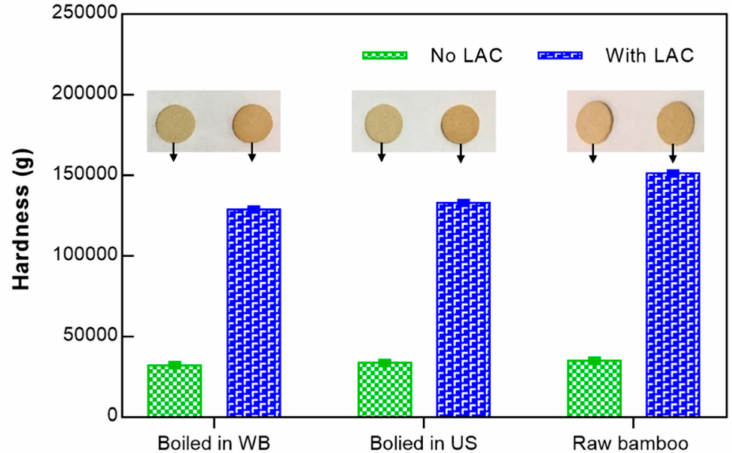
Figure 5. The hardness of the raw bamboo tablets and of the bamboo tablets produced after 30 min of boiling using a water bath and an ultrasonic bath; the tablets were produced by laccase action and heating at 40 ◦ C, under 5000 kg of pressure (the hardness values are the mean of 2